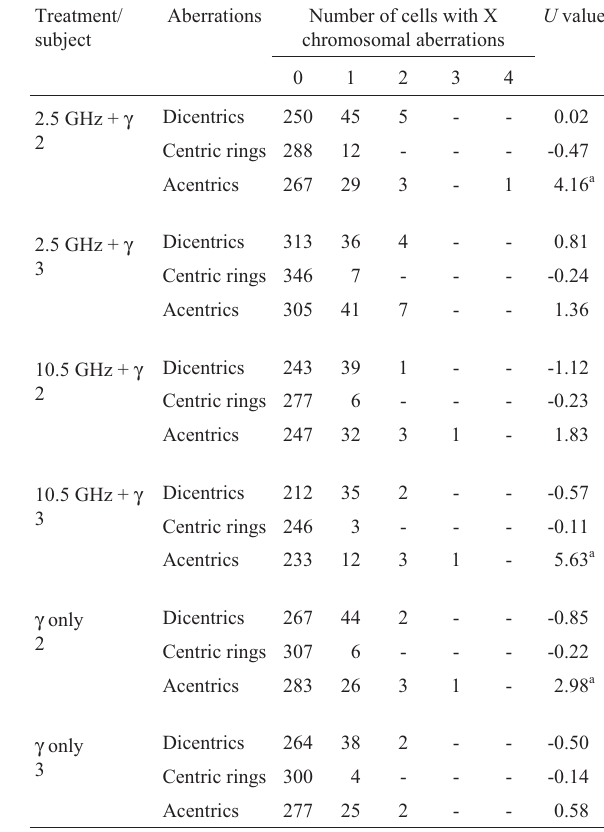
Table 4 - Distribution of the chromosome-type structural aberrations among the scored cells in Table